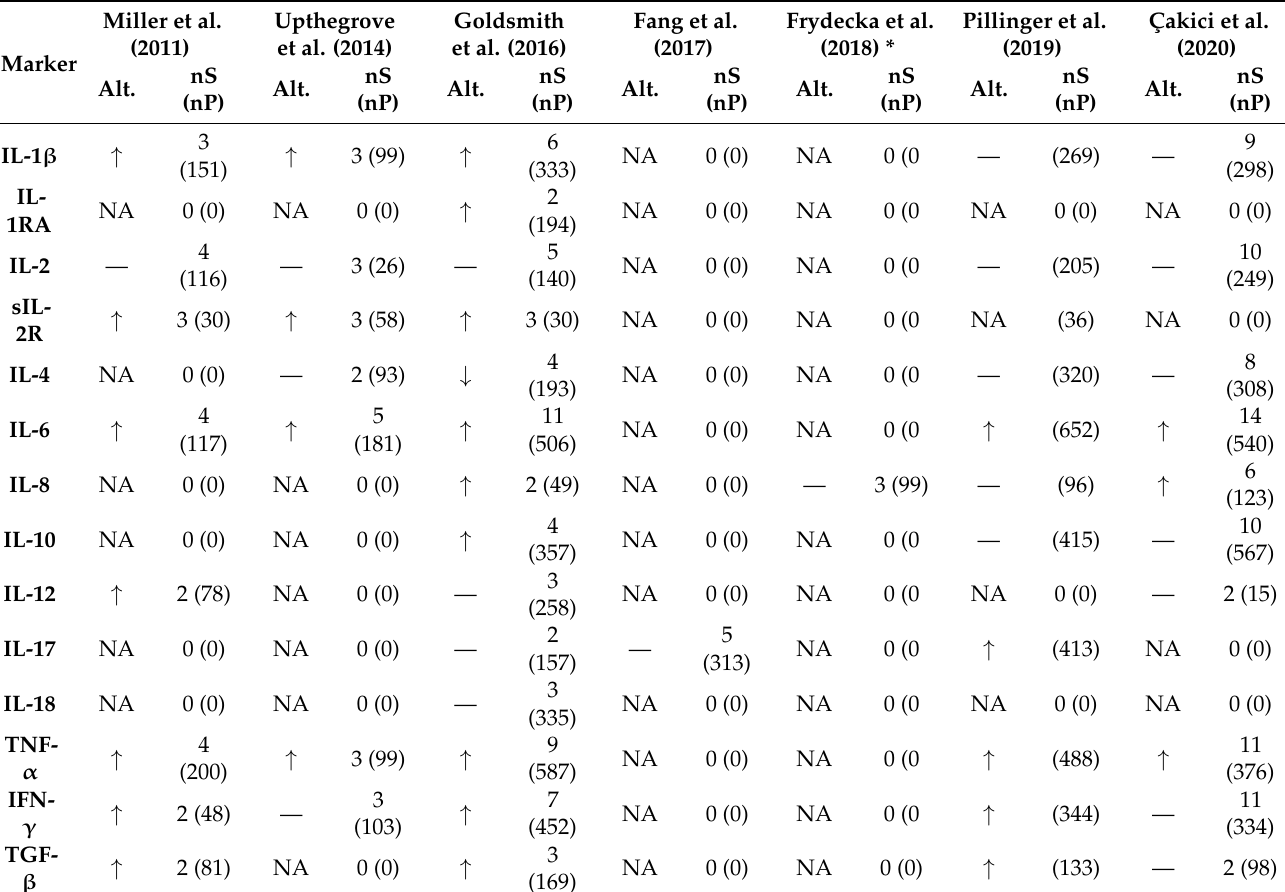
Table 1. Summary of meta-analytical data concerning peripheral cytokine levels in first episode psychosis (FEP) and first episode drug naïve (FEAN) patients as compared to healthy controls. Miller et Marker